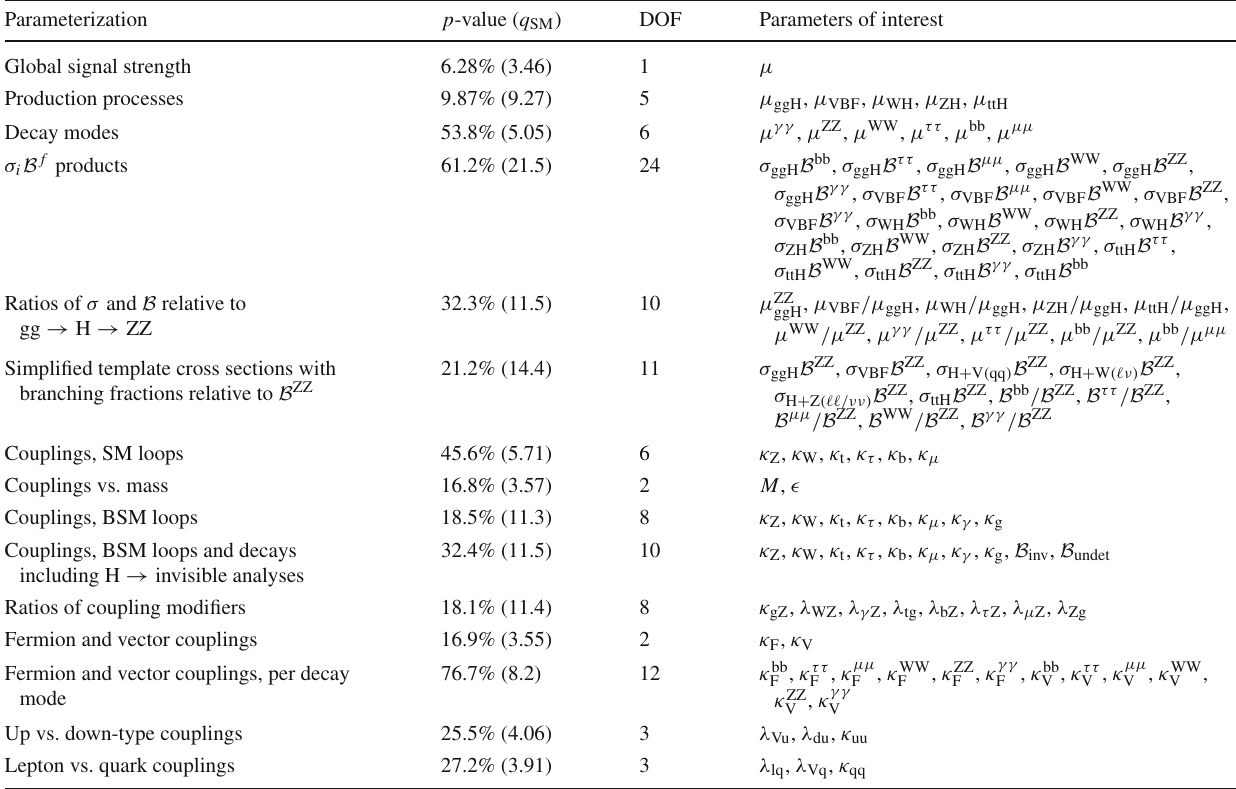
Table 12 Compatibility of the fit results with the SM prediction under various signal parametrizations. The value of q at the values of the POIs for which the SM expectation is obtained ( q SM ) is shown along with